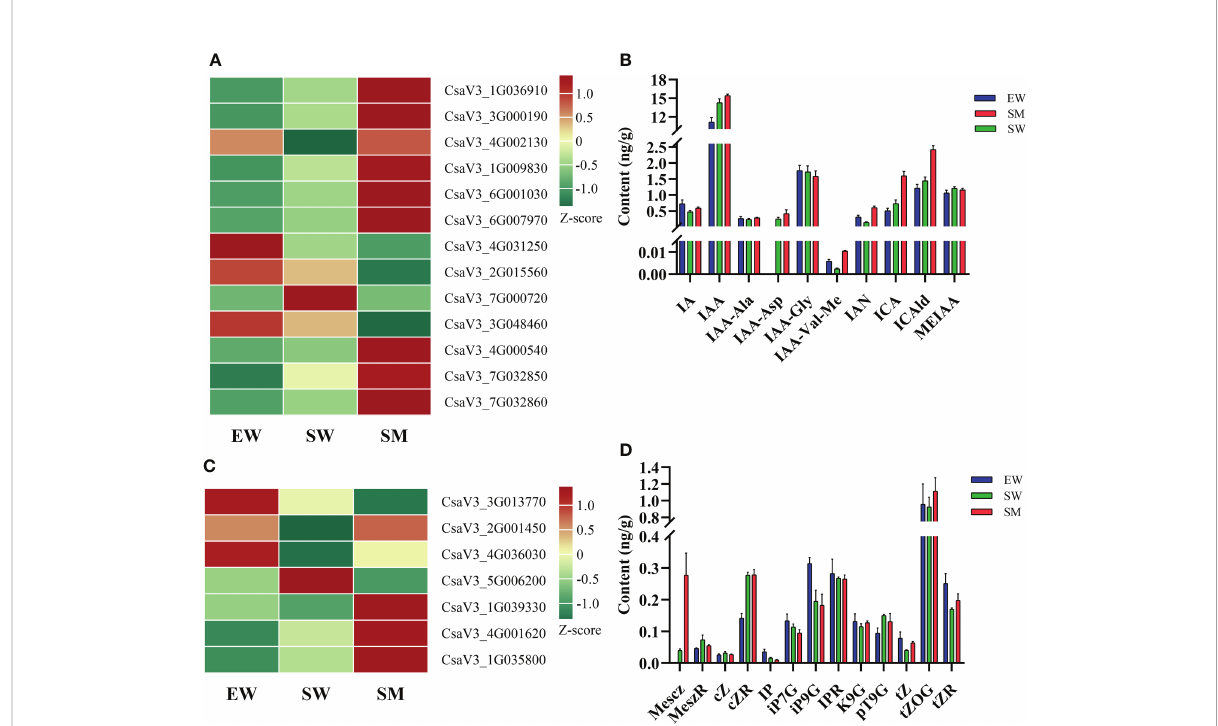
FIGURE 4 Effects of melatonin on genes and hormones related to auxin and cytokinin in cucumber seedings. (A, B) Effects of melatonin on the expression of auxin-related genes and auxin content. (C, D) Effects of melatonin on the expression of cytokinin-related genes and cytokinin content. EW (hypocotyl exposed and irrigated with water), SW (hypocotyl shaded and irrigated with water) and SM (hypocotyl shaded and irrigated with 100 µM